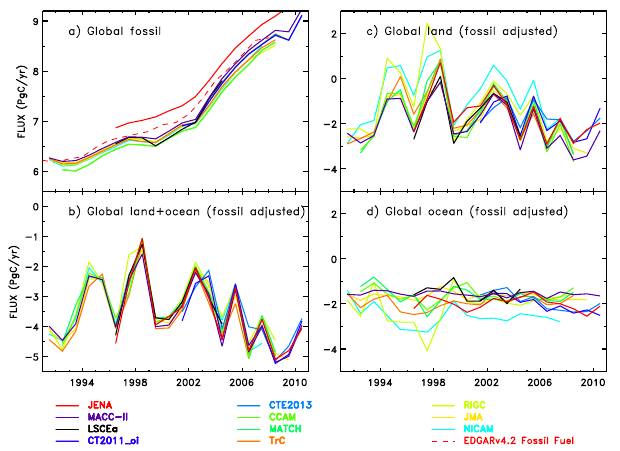
Fig. 2. Annual mean posterior flux of the individual participat- ing inversions for (a) fossil fuel emission, (b) natural “fossil-fuel- corrected” global total carbon exchange, (c) natural “fossil-fuel- corrected” total land and (d) natural “fossil-fuel-corrected” total ocean